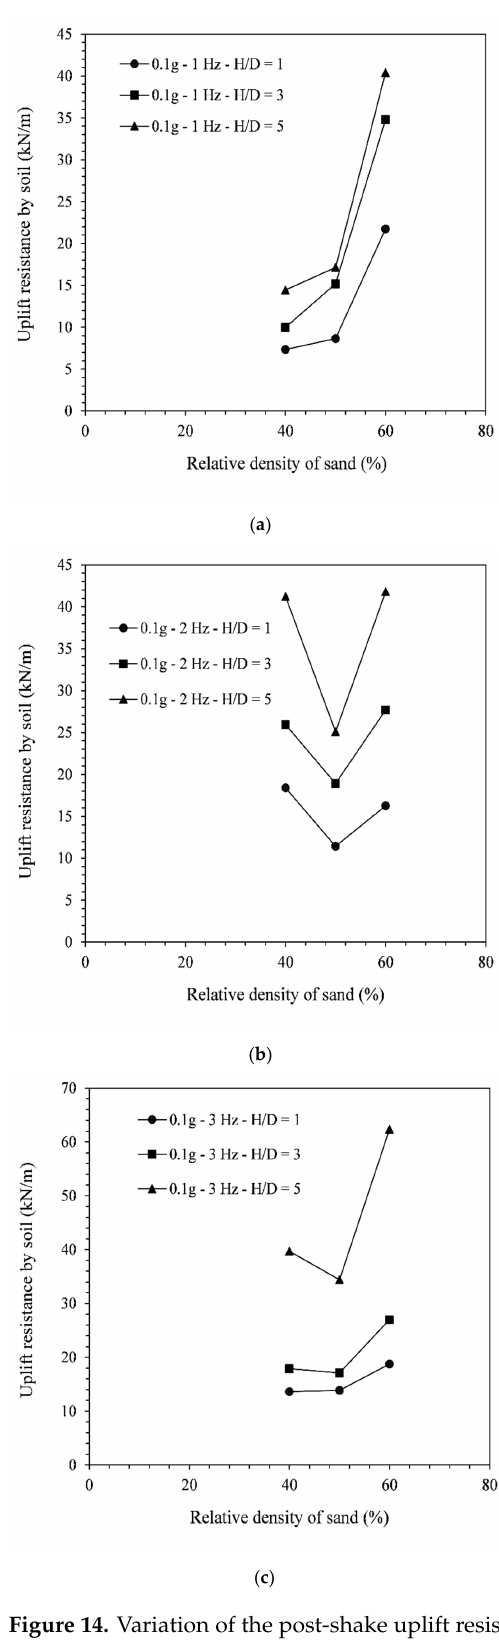
Figure 14. Variation of the post-shake uplift resistance with the relative density of the backfill soil for different pipe embedment depths, a seismic signal of amplitude 0.1 g and frequencies ( a ) 1 Hz, ( b ) 2 Hz and ( c ) 3 Hz.